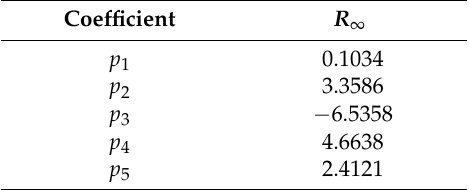
Table 2. Coefficients of the Albert-Mobley model for the infinite medium depth